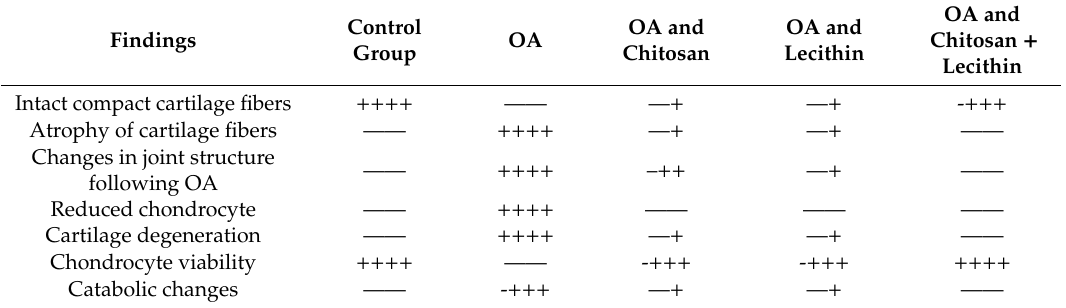
OA and OA and OA and Control Chitosan + OA Chitosan Lecithin Group Lecithin